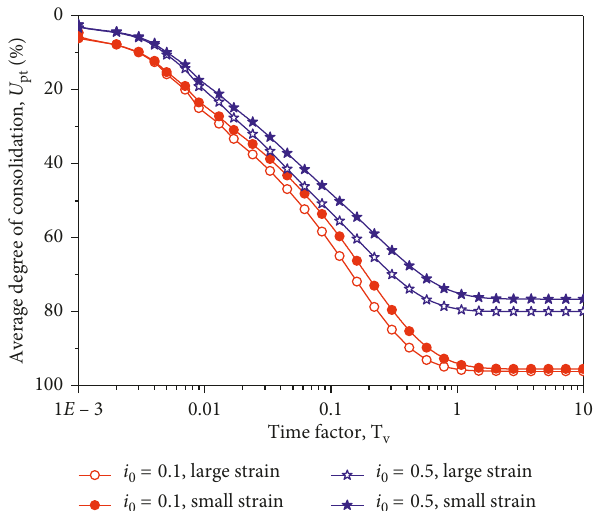
Figure 11: Influence of geometric supposition on U pt under ferent preconsolidation pressure.